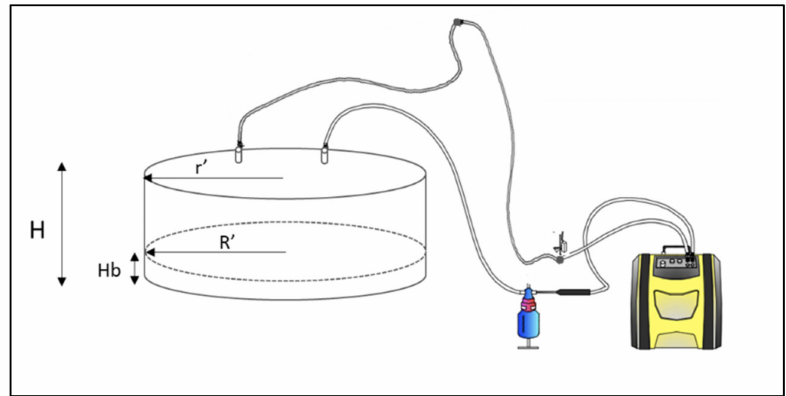
Figure 1. Setup for the gas measurements using a dynamic